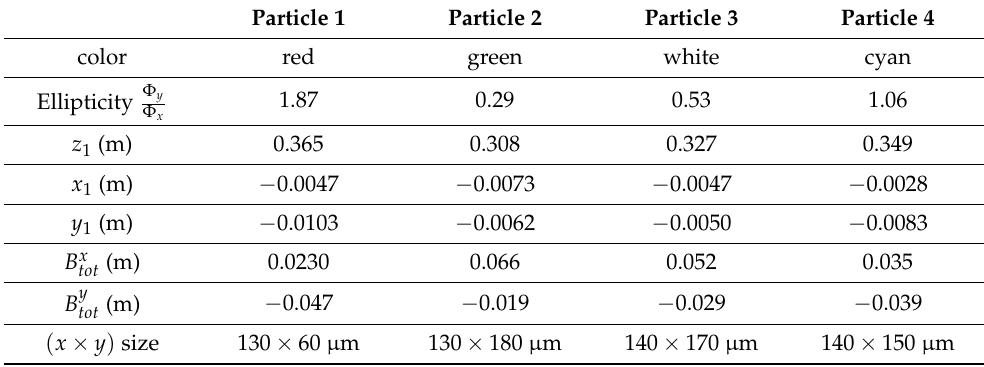
This work is repeated for particle 2, encircled in green in Figure 7. The selected pattern, its scaled 2D Fourier transform in the logarithmic scale, and its binarization are presented in Figure 10a–c, respectively. In this case, the dimensions of the particle are estimated to be 130 × 180 µ m.